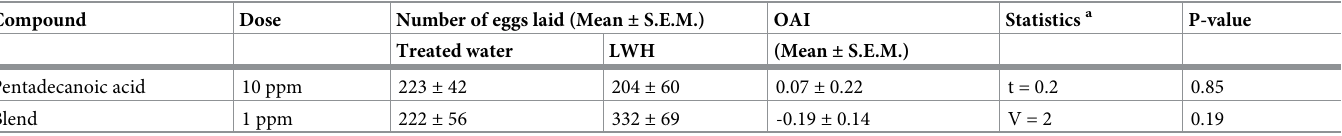
Table 2. Oviposition responses of Ae . aegypti gravid females towards synthetic compounds compared to LHW at 100 larvae / 100 mL (OAI: Oviposition activity index calculated towards the synthetic compounds). Compound Dose Number of eggs laid (Mean ± S.E.M.) OAI Statistics a P-value Treated water LWH (Mean ± S.E.M.) Pentadecanoic acid 10 ppm 223 ± 42 204 ± 60 0.07 ± 0.22 t = 0.2 0.85 Blend 1 ppm 222 ± 56 332 ± 69 -0.19 ± 0.14 V = 2 0.19